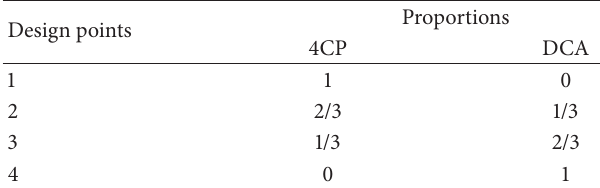
Table 1: Simplex-lattice {2, 3} experimental